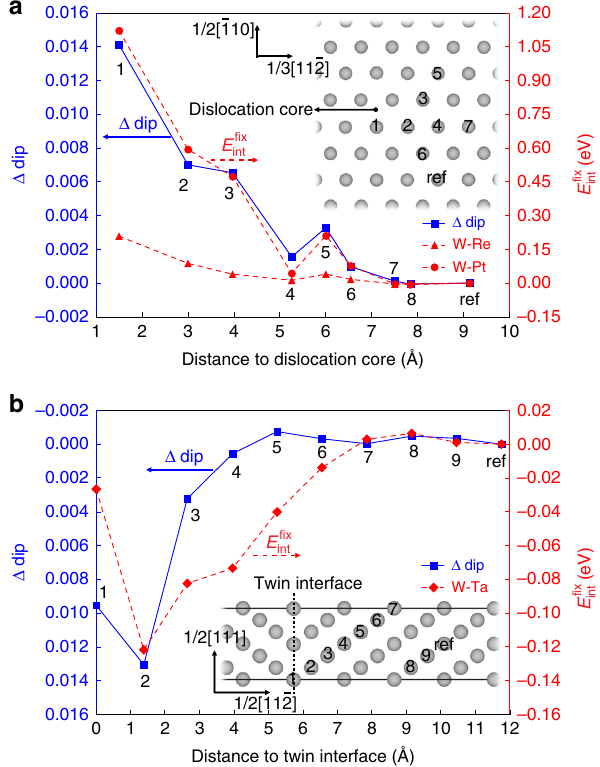
in W binary alloys. Fig. 2 Correlation between Δ dip of LDOS and E fix int interaction energy calculated based on the defect structures that are already fully relaxed in pure W and without further relaxing atomic positions after solute substitution. The calculated Δ dip (blue squares) of each atomic site of interest in pure W, and the corresponding solute – defect interaction energy when the site is occupied by Re (red triangles), Pt (red circles), and Ta (red diamonds) are plotted with respect to the relative distance from the atomic site to the defect center. The positions of the Þ TB, atomic sites in the simulation cell are marked by numbers according to the pairing distance with the defect center and the investigated site. It should be noted that the axis value for the Δ dip term in b is plotted in reverse order (i.e. higher Δ dip values pointing